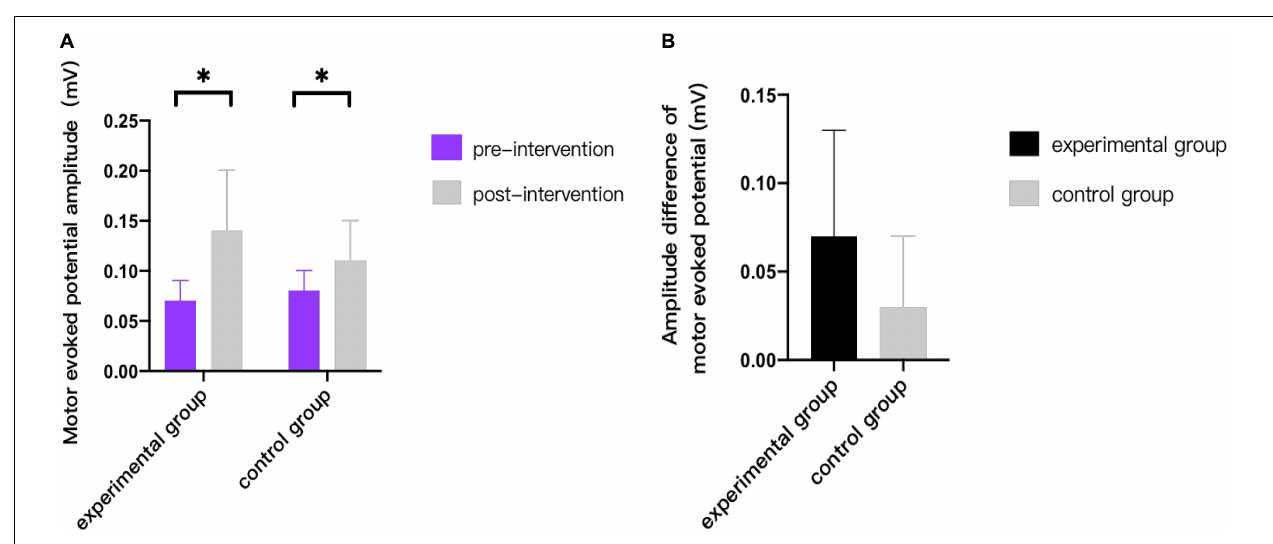
FIGURE 8 | Comparison of amplitude of motor evoked potentials. * indicates intra-group p <